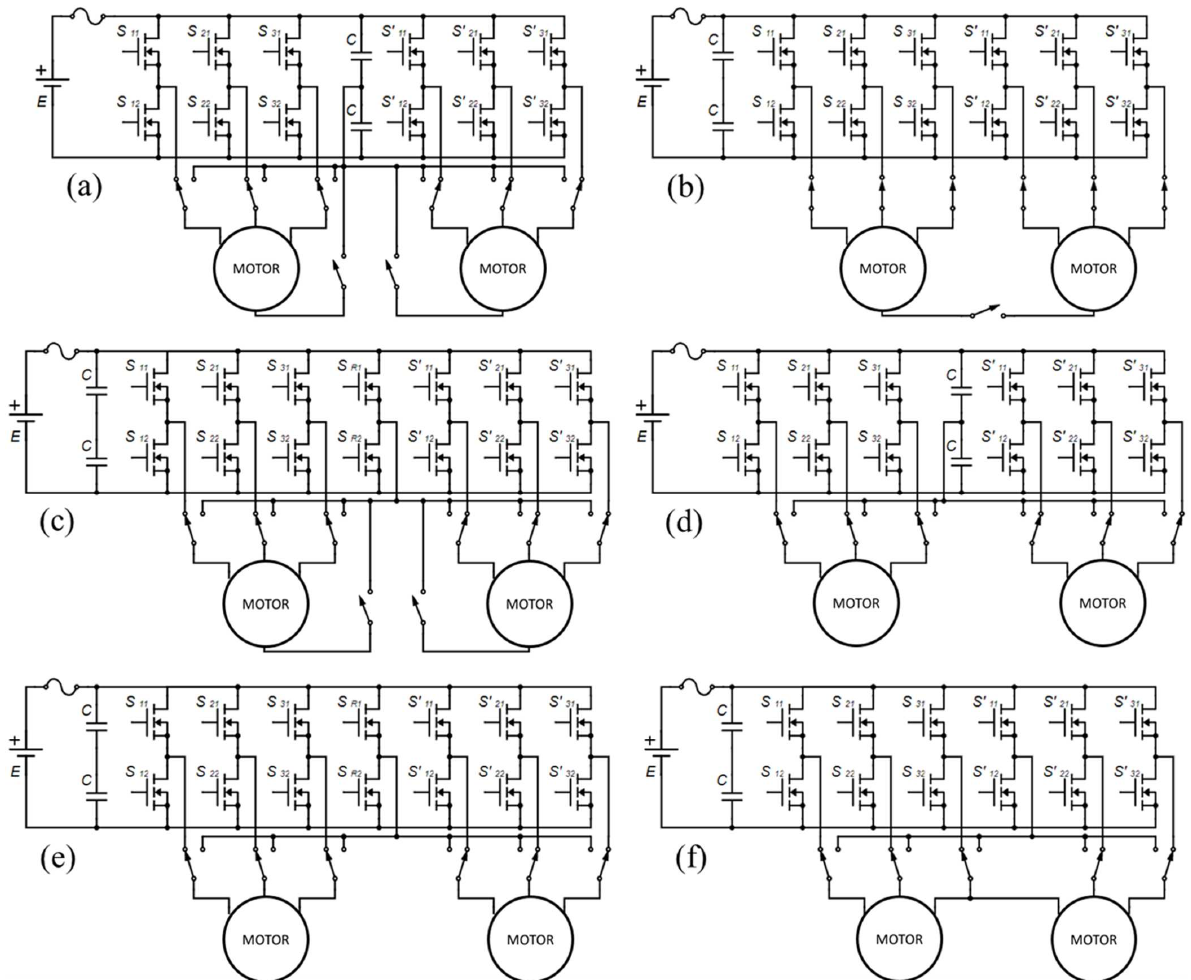
Figure 14. Proposed Fault tolerant Inverter topologies for dual-motor systems: ( a ) TPMO, ( b ) SPCM, ( c ) FLI, ( d ) DCM, ( e ) LRI, ( f ) SL-LRI.